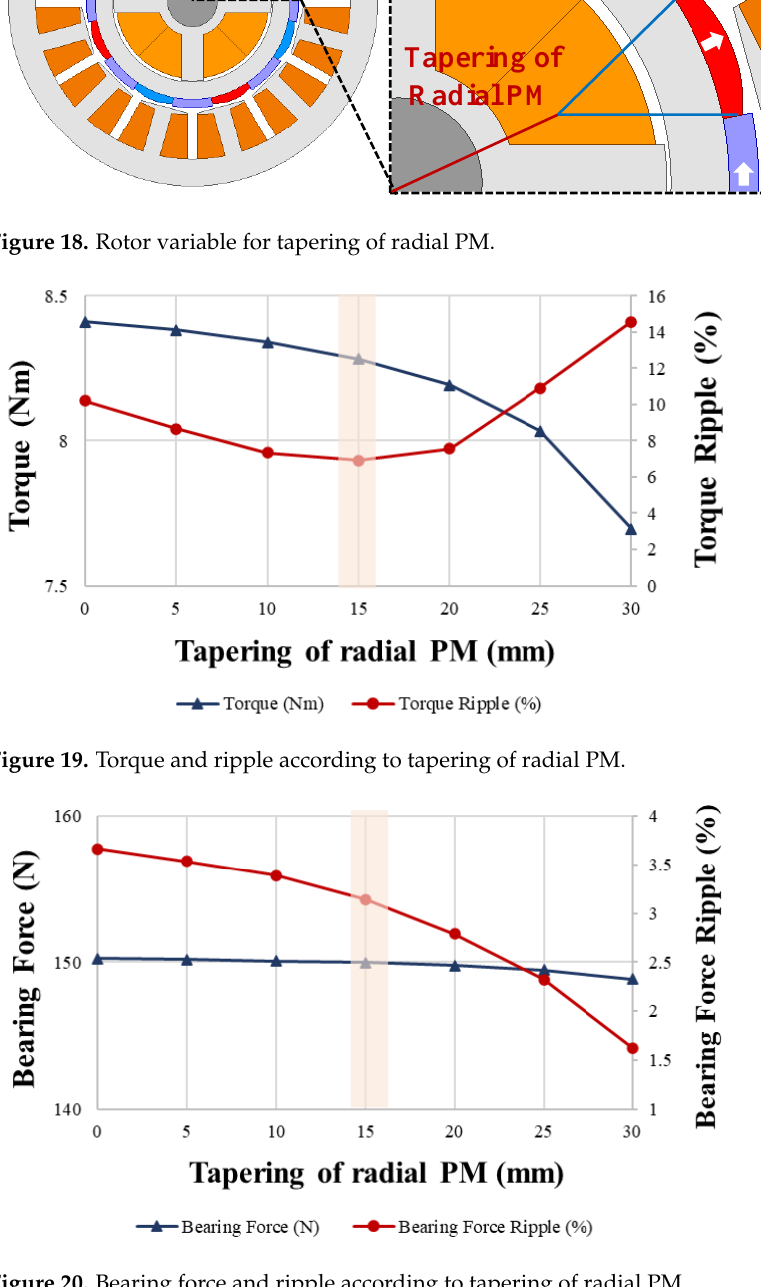
Figure 20. Bearing force and ripple according to tapering of radial PM.